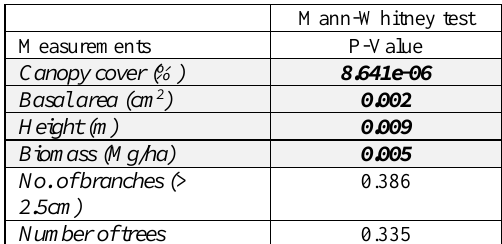
Table 2. Results of Mann-Whitney test for forest variables.